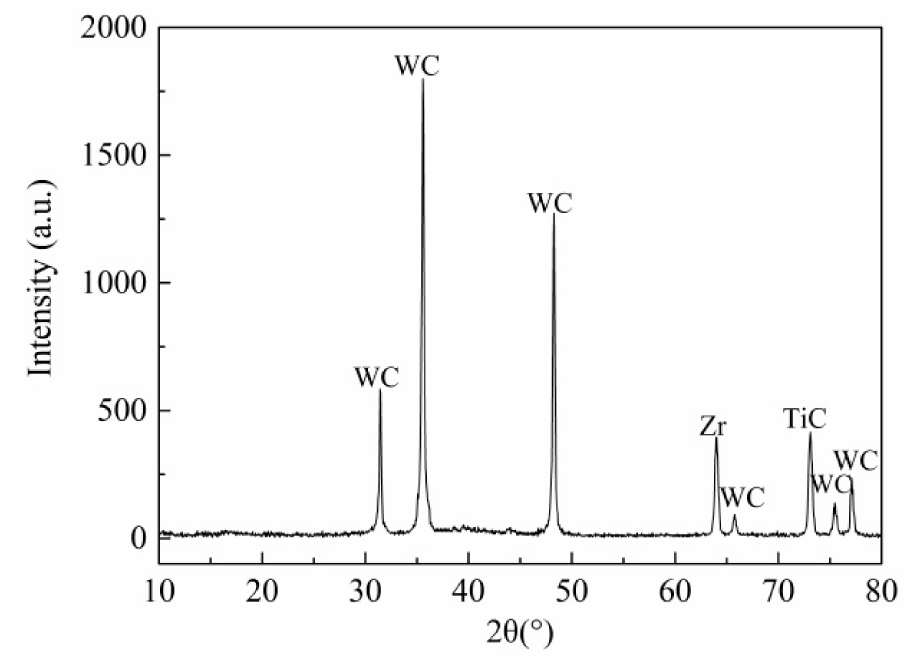
Figure 3. X-ray diffraction analysis of the T180 sample.